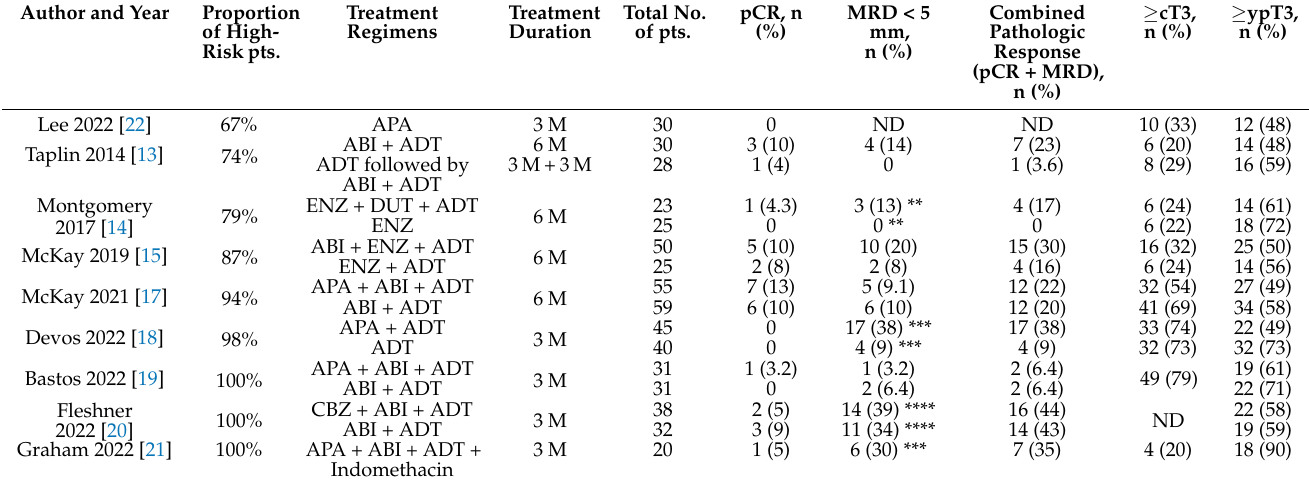
Table 2. Summary of pathological responses to neoadjuvant ARSI-based therapies of included phase II clinical